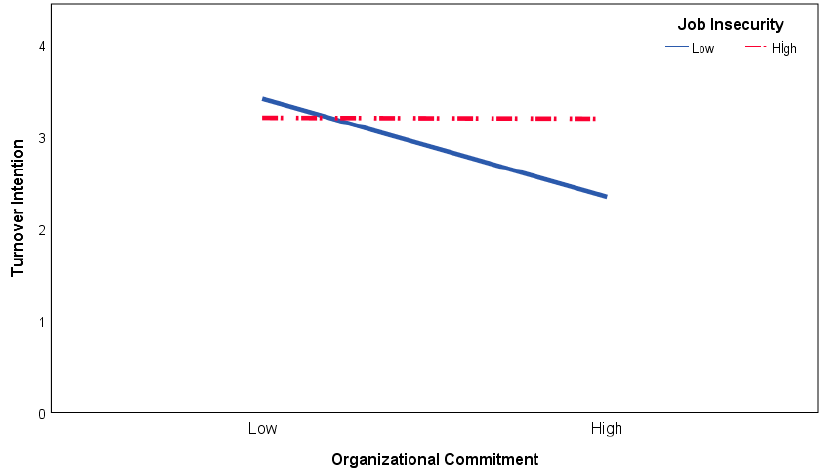
Figure 3. Moderating role of job insecurity on organizational commitment–turnover intention re- lationship.